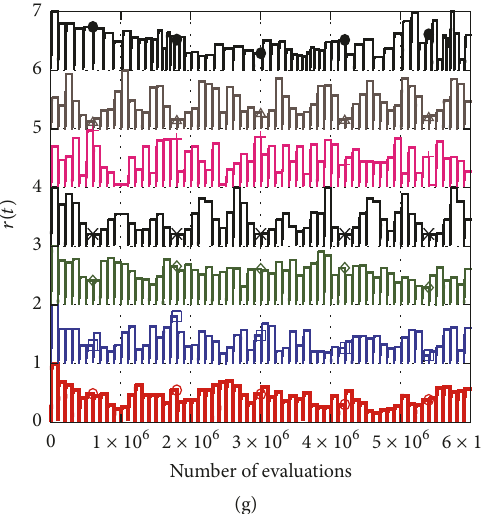
Figure 2: Convergence graph of Shrinking-based BA for (a) 𝐹 1 ( 𝑚 = 10 ), (b) 𝐹 1 ( 𝑚 = 50 ), (c) 𝐹 2 , (d) 𝐹 3 , (e) 𝐹 4 , (f) 𝐹 5 , and (g) 𝐹 6 where relative values ( 𝑟(𝑡) ) are presented for each 𝑇 𝑖 as 𝑟(𝑡) + 𝑖 − 1 , where 0 ≤ 𝑟(𝑡) ≤ 1 and 𝑖 = 1, 2, .. ., 7